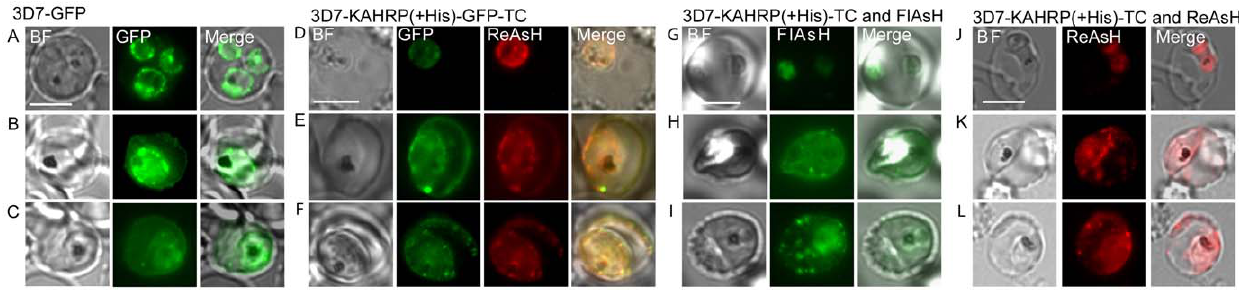
Figure 3. KAHRP protein trafficking in PEs. (A–C) Bright field (BF) and GFP fluorescence images of PEs containing Pf 3D7 parasites transformed to express KAHRP( + His)-GFP protein without TC tag. (D–F) Images of 3D7-KAHRP( + His)-GFP-TC PE labeled with ReAsH and photographed in the green and red channels separately for GFP and ReAsH fluorescence. (G–I) Images of 3D7-KAHRP( + His)-TC PE labeled with FlAsH. (J–L) Images of 3D7- KAHRP( + His)-TC PE labeled with ReAsH. The emission crossover between green and red channels was negligible, and was estimated to be less than a 1% leak of GFP emission into the ReAsH emission channel. Scale bar represents 5 m m.